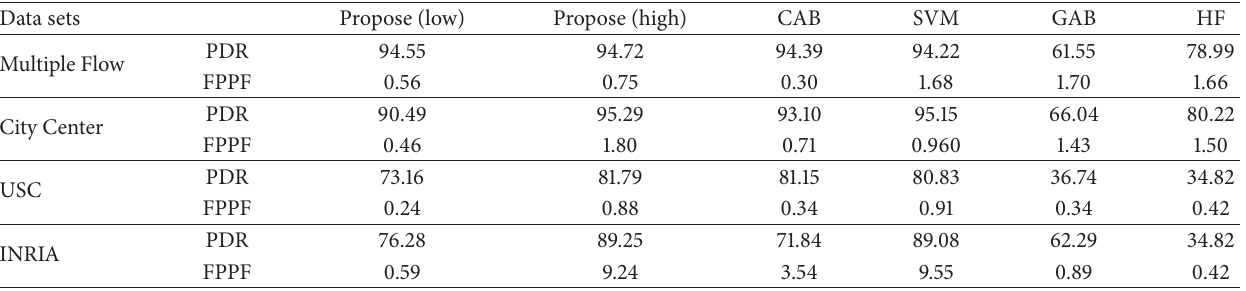
Table 1: Pedestrian detection rate (%) and false positives per frame comparison of CAB-ELM and other state-of-the-art detectors. Data sets